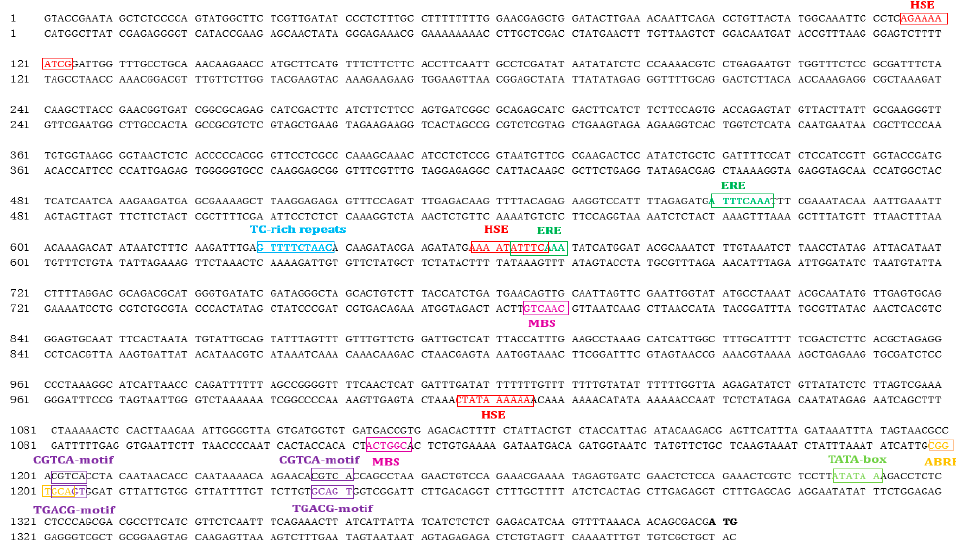
Figure 1. Sequence feature of BocMBF1c protein. ( a ) DNA and amino acid sequence of BocMBF1c. Full-length DNA and deduced amino acid sequence of BocMBF1c. Red underline indicates multi-protein bridging factor1 (MBF1) gene family domain, and green underline signatures helix-turn-helix (HTH) domain. ( b ) Phylogenetic tree constructed by the neighbor-joining method based on the MBF1c amino acid sequences.